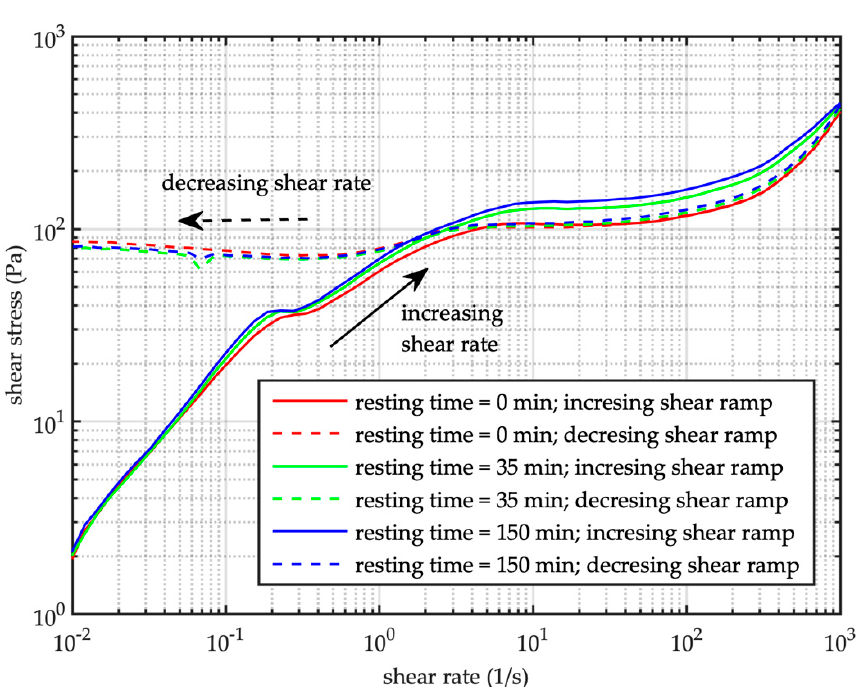
Figure 8. Flow curves ( C = 52%) after different resting times (runs F9, F10, F11 in the legend from the top to the bottom).